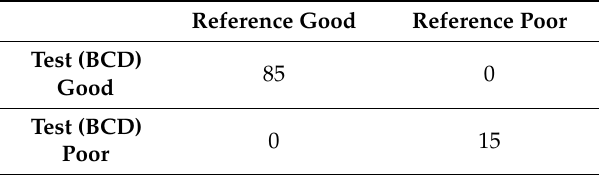
Table 2. Concordance in classification of clinical results for the BCD and the reference